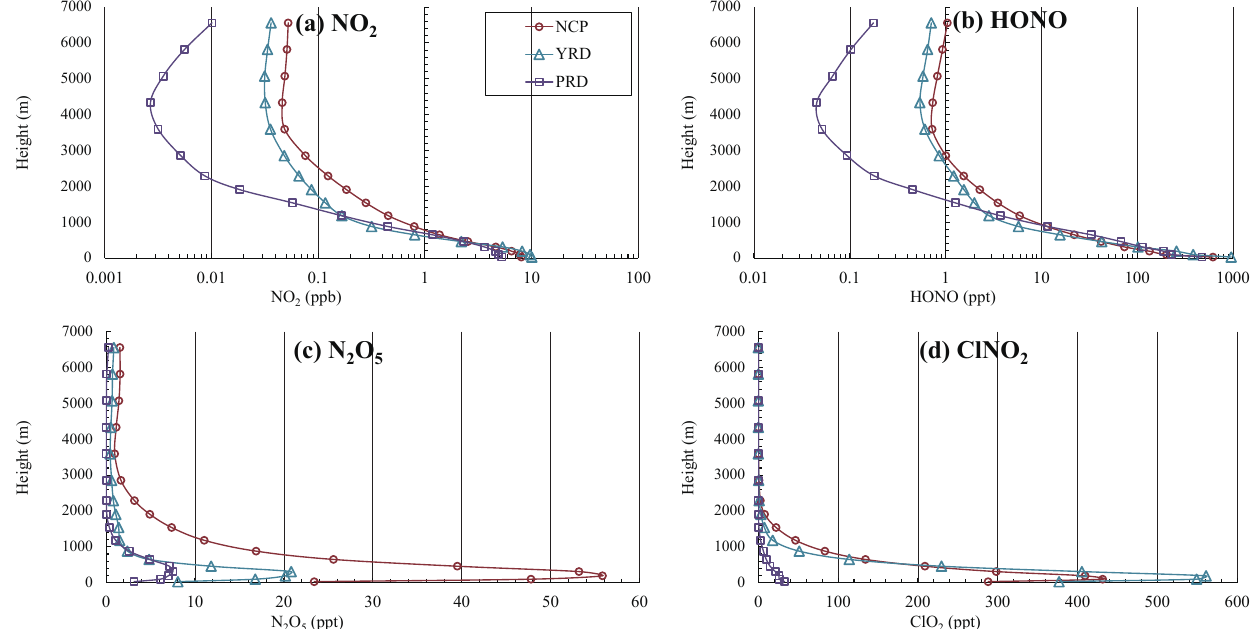
Figure 4. Vertical distributions of WRF-Chem-simulated regional averages of (a) NO 2 (ppb), (b) HONO, (c) nighttime N 2 O 5 , and (d) night- time ClNO 2 (ppt) over the NCP, YRD, and PRD